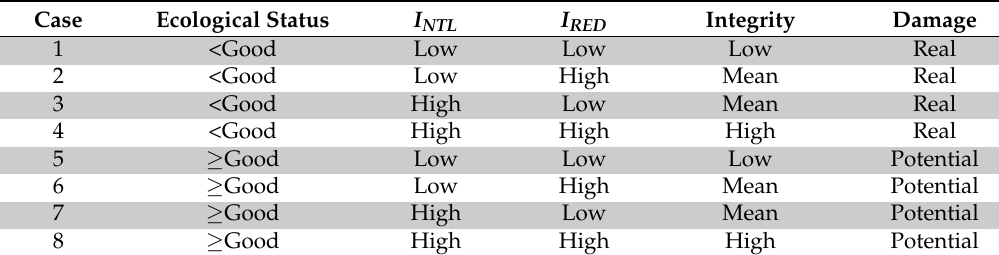
Table 4. The eight possible cases occurring in the river